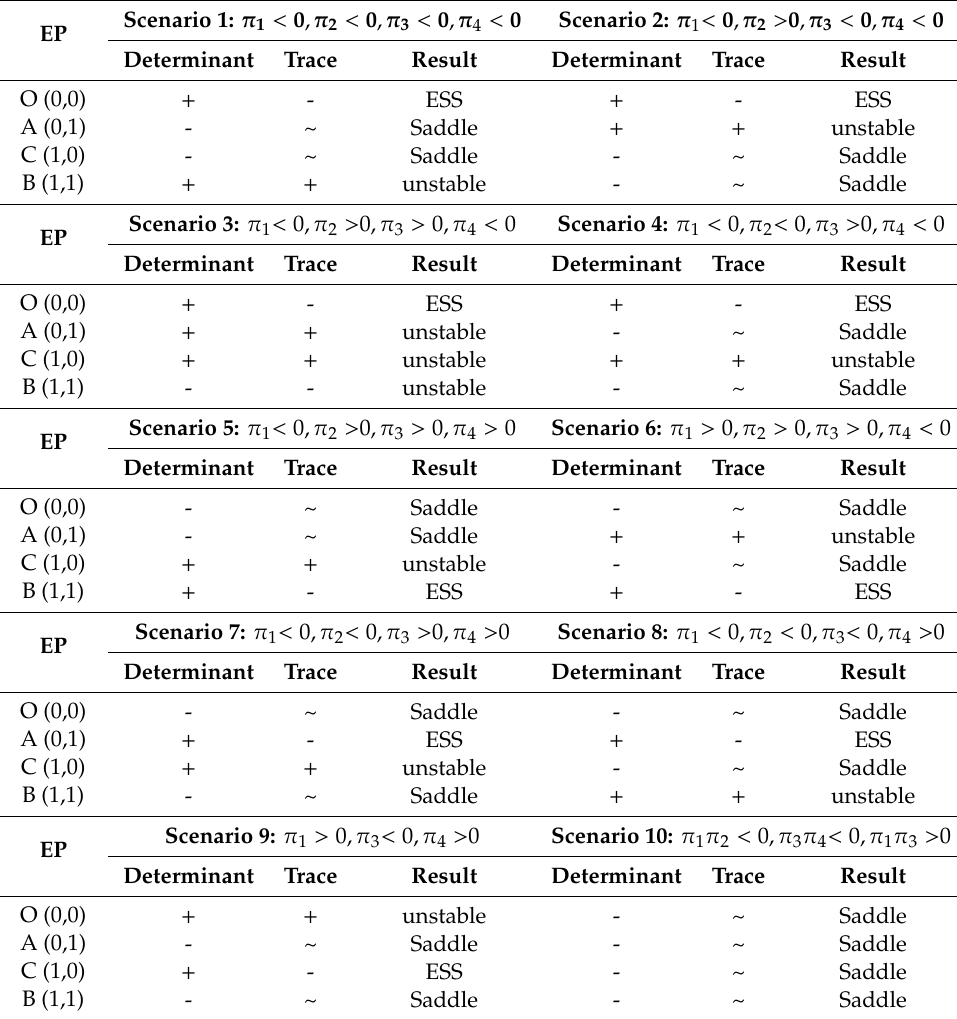
Table 3. Local stability analysis of equilibrium points